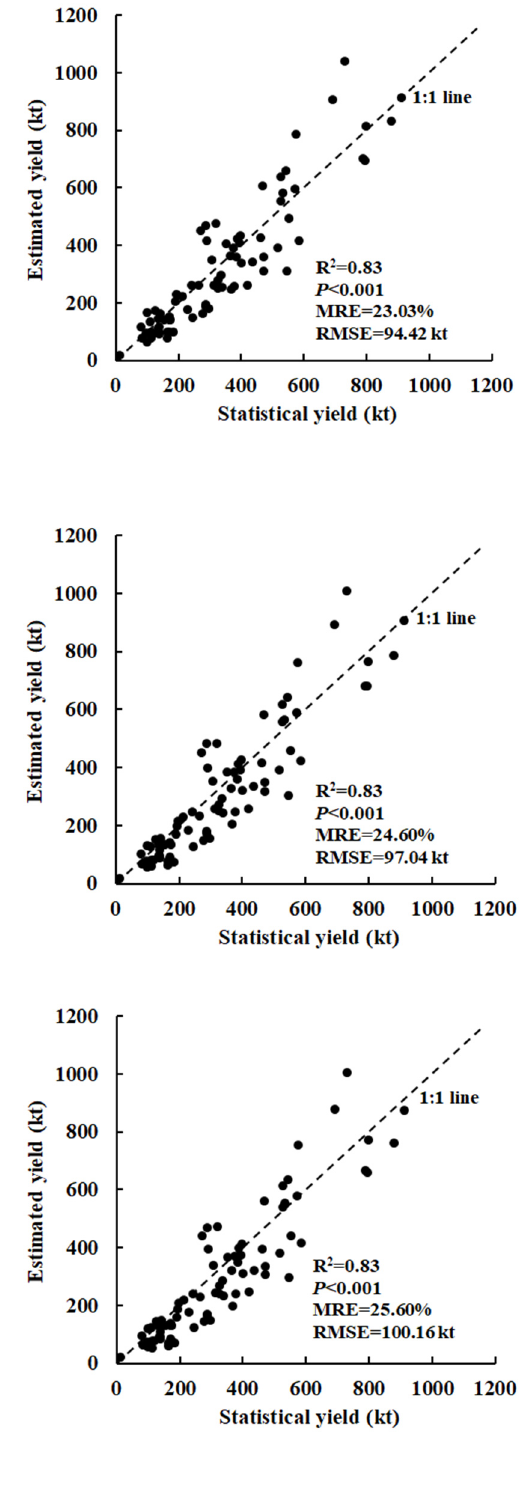
Figure 11. R 2 , MRE and RMSE for the relationships between the statistical and estimated yields at the municipal (left) and county (right) levels in Henan Province, which were obtained with the LSTM (a), 1-D CNN (b) and RF (c) models. Kiloton = kt.